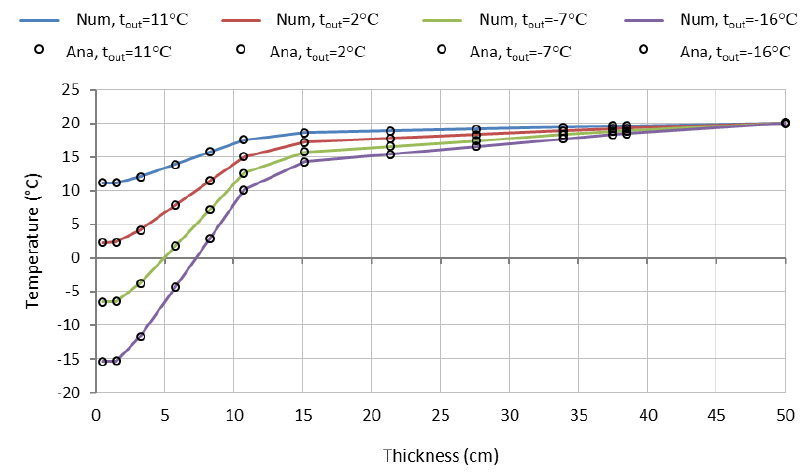
Figure 7. Comparison of the numerical calculation results with the analytical results for different values of ambient temperature.